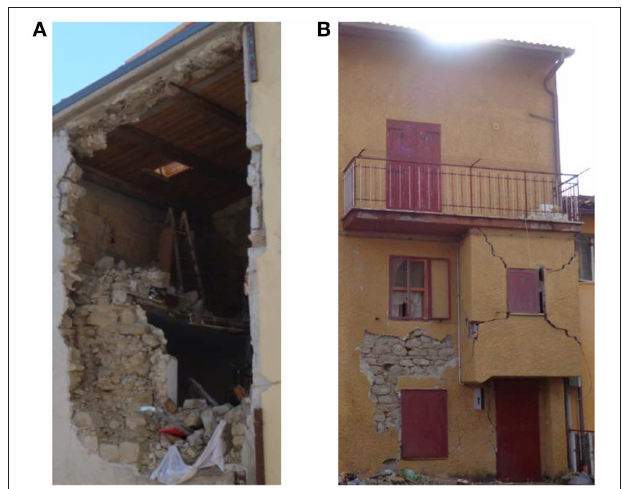
FIGURE 6 | Structural features: (A) Three-leaf masonry walls. (B) Example of a building negatively affected by improper